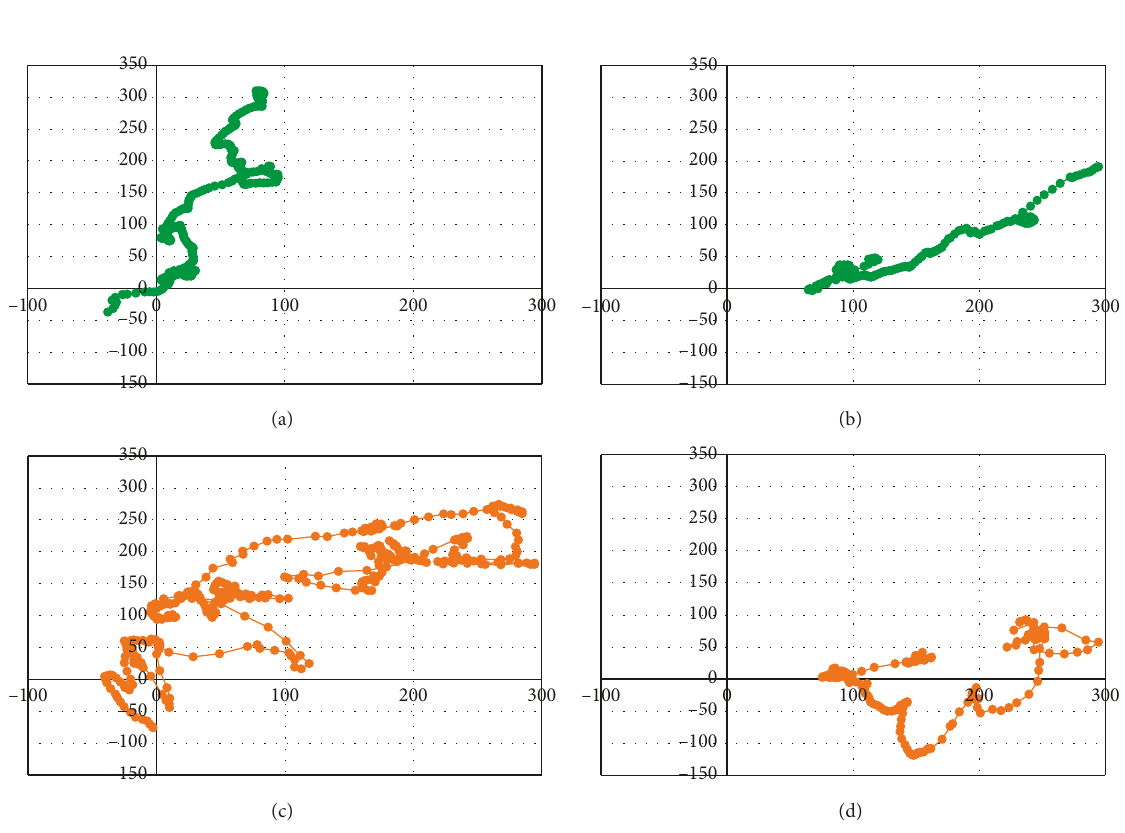
Figure 6: Displacement (km) from the storm center (located at 0, 0) at each observation time for (a) Jeanne 20 dB Z , (b) Humberto 20dB Z , (c) Jeanne 40dB Z , and (d) Humberto 40dB Z regions. Positive Y -axis extends to the north, and positive X -axis extends to the